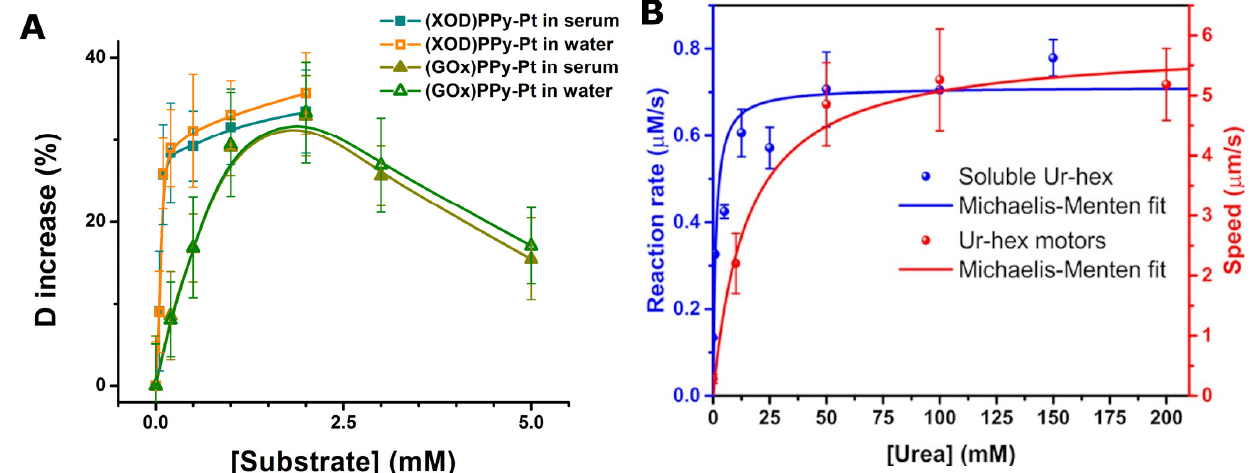
Figure 5. ( A ) The dependence of the relative diffusion coefficient of XOD-modified nanorods and of GOx-modified nanorods on the concentration of hypoxanthine and glucose, respectively, in water and in 10 × diluted serum; ( B ) The dependence of the reaction rate (in blue) and of the self-propulsion speed (in red) of silica microcapsules modified with urease on the concentration of urea in water; Figures reproduced with permission from Ref. [6] (panel ( A )) and from Ref. [38] (panel ( B )).